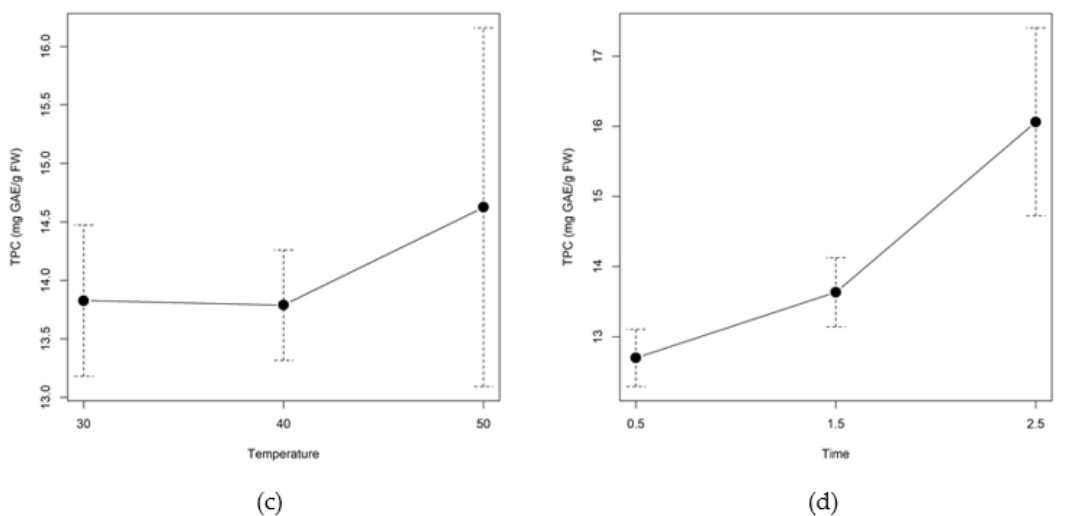
Figure A3. The total phenolic content (TPC; mg GAE/g FW) in ethanolic extracts plotted as a function of the ( a ) enzymatic mix with laccase, cellulose, and pectinase at proportions of 1:1:1 (LCP), 1:1:2 (LCPP), and 0:1:2 (CPP), ( b ) pH (4–6), ( c ) temperature (30–50 ◦ C), and d) time (0.5–2.5 h).